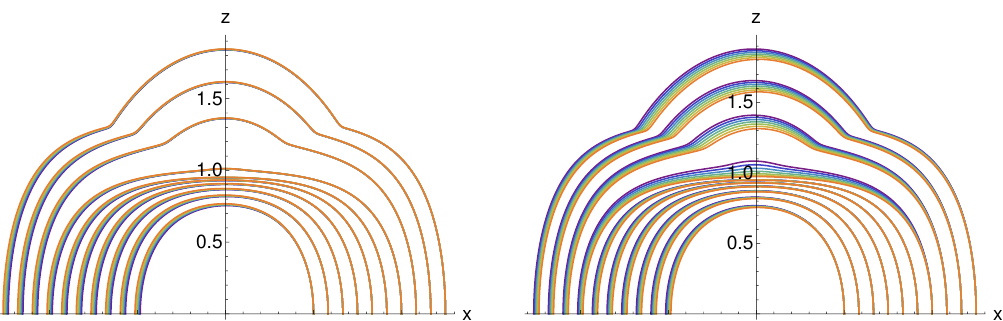
Figure 4: Families of geodesics used to compute QNEC. Colors from blue to red de- note family members p = − 3 to p = + 3, as discussed in the main text. Left: In this plot we use a deformation vector ( k region. Right: This plot is for a deformation vector ( k entangling region. Both plots are for fixed value of the quench parameter a = 30 and time t = 2.0 and we used for illustrative purposes a rather large deformation ε =